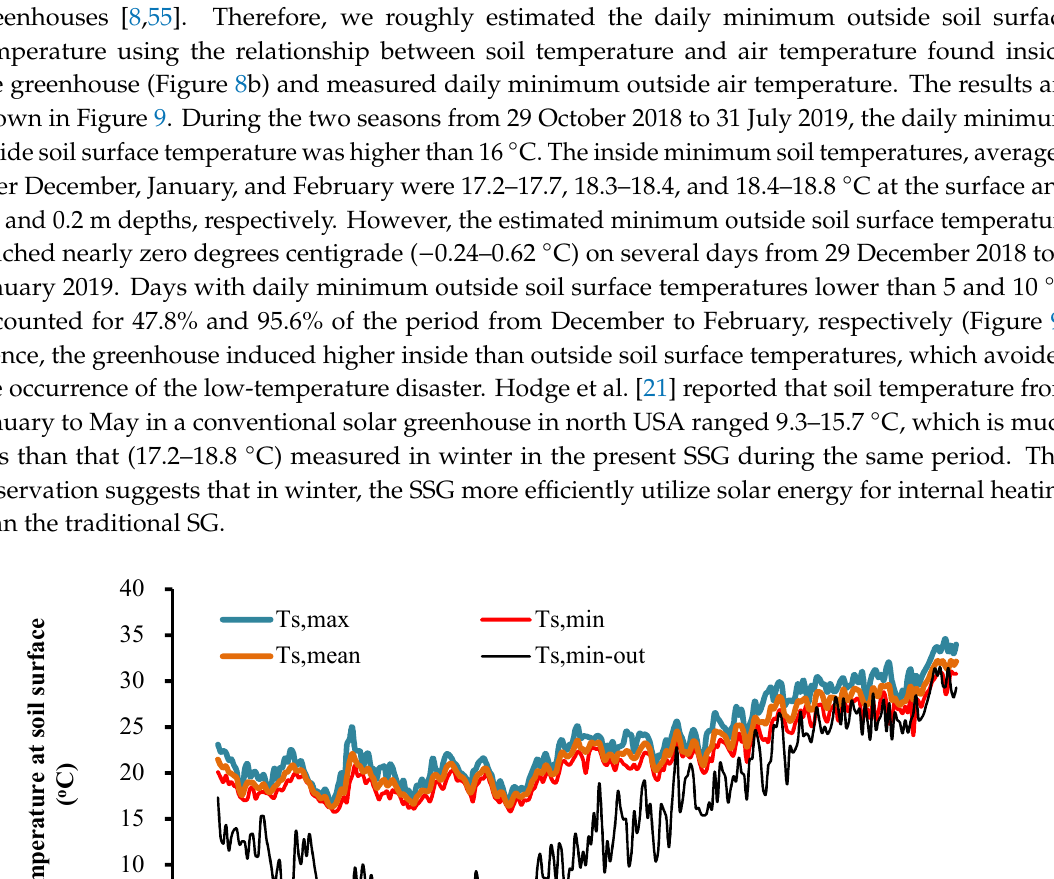
17 of 26 Figure 8. Relationships between daily maximum ( a ), minimum ( b ), and mean ( c ) soil surface temperature to the corresponding daily air temperatures in and out of the sunken solar greenhouse,